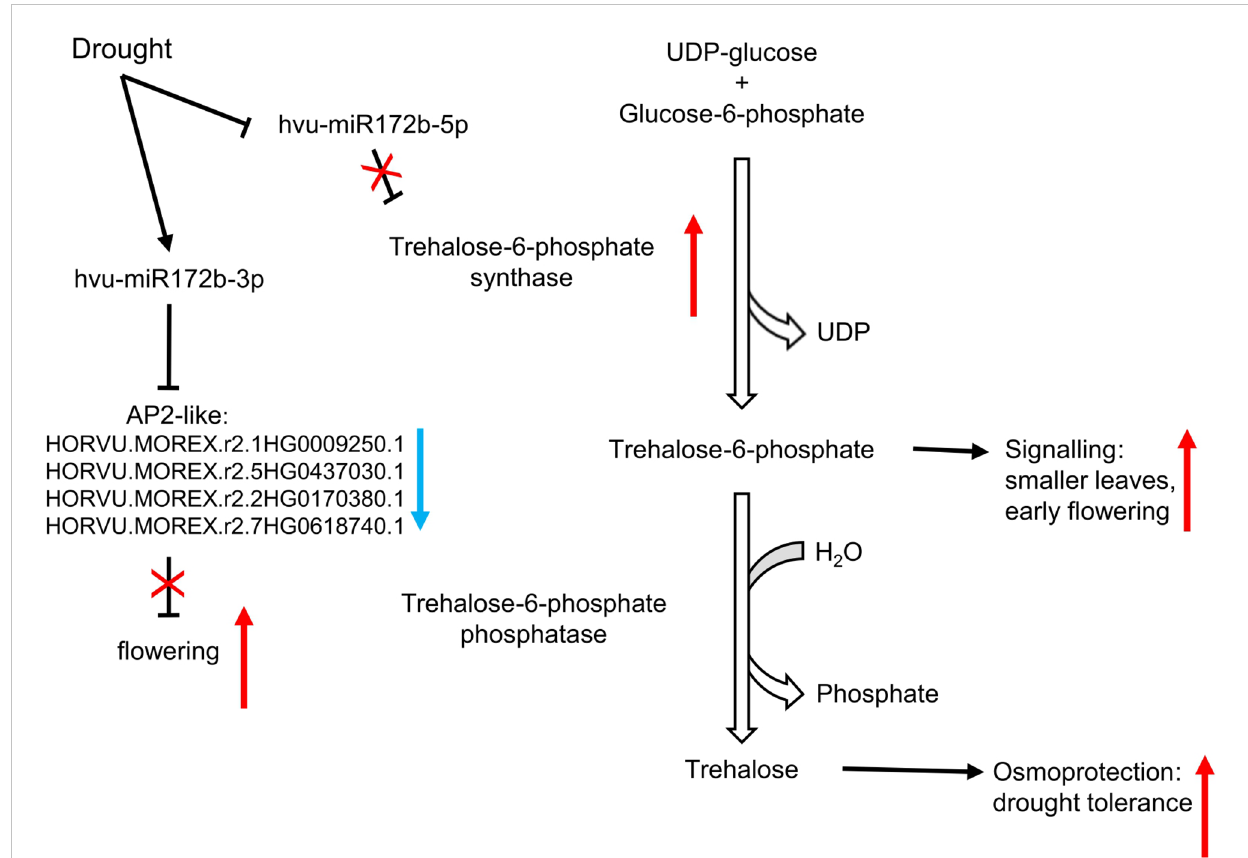
FIGURE 8 Drought as a stimulus of induced fl owering via hvu-miR172b-5p/trehalose-6-phosphate synthase and hvu-miR172b-3p/AP2-like modules. The two microRNAs act consistently to speed up fl owering by distinct